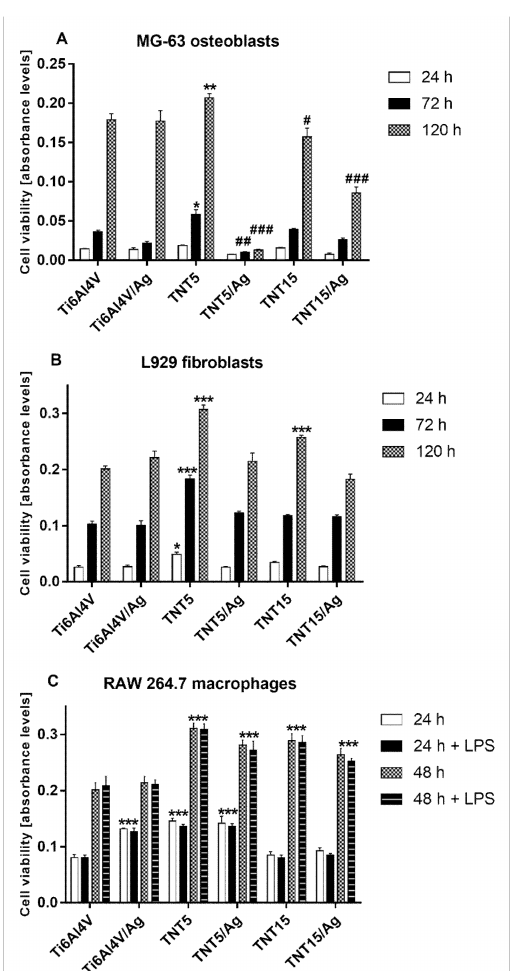
Figure 2. Proliferation of human osteoblast-like MG 63 cells ( A ), L929 murine fibroblast cells ( B ), and murine macrophage cell line RAW 264.7 ( C ) on the surface of TiO 2 nanotube coatings analyzed by the MTT assay (a colorimetric assay for assessing cell metabolic activity). MG-63 osteoblasts and L929 fibroblasts were cultured on the specimens for 24, 72, and 120 h, whereas RAW 264.7 macrophages were cultivated for 24 and 48 h in the presence or absence of LPS (Lipopolysaccharide). The absorbance values are expressed as means ± SEM of five independent experiments. Asterisks indicate significant di ff erences comparing to the reference Ti6Al4V alloy foils (Ti6Al4V) (*** p < 0.001, * p < 0.05). Hash marks denote significant di ff erences when the level of cell proliferation was lower in comparison with the reference Ti6Al4V alloy foils (### p < 0.001, ## p < 0.01, # p <